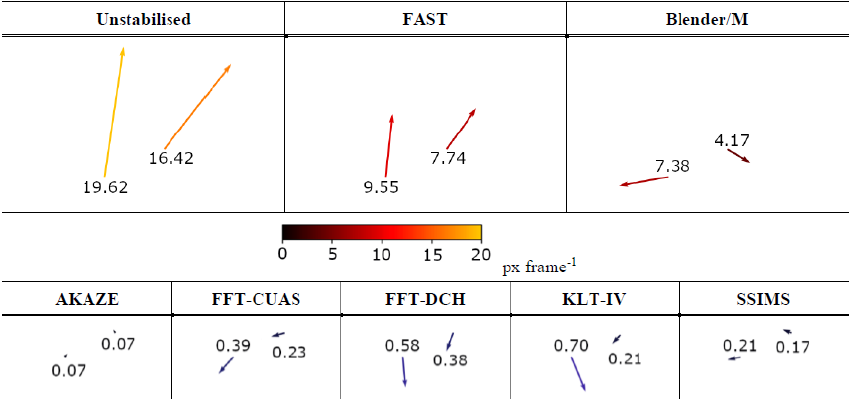
Table 4. Aggregated SVF analysis results of both unstabilised and stabilised videos for the Alpine case study. The mean u and v components of the apparent motion of static features on each of the two islands are illustrated by vector size and orientation. Numeric values illustrate the mean apparent velocity magnitude for both